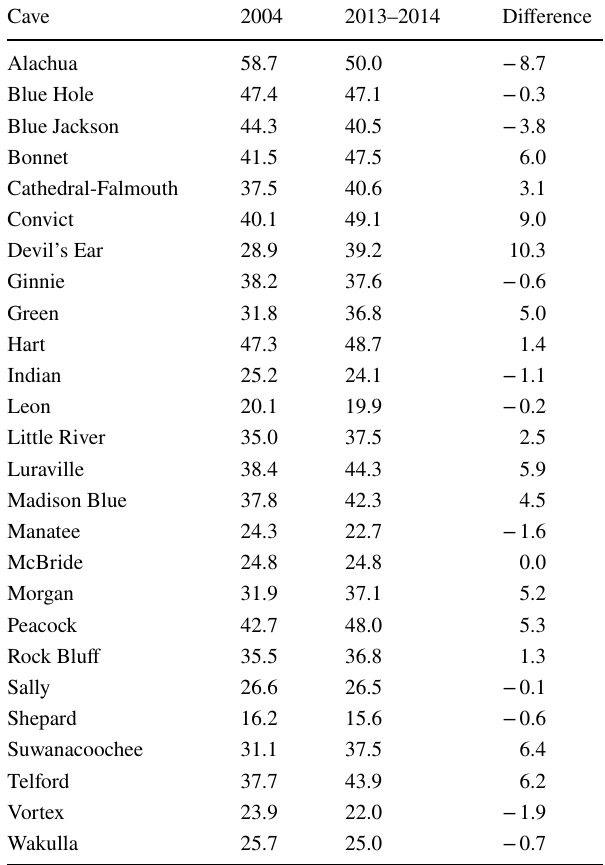
Table 1 Land use categories Land use code and